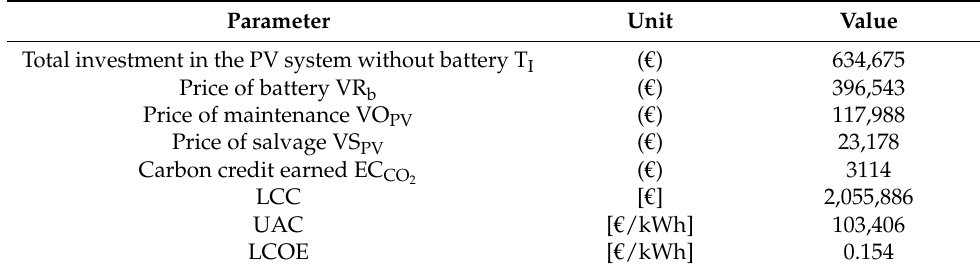
Table 8. Results of the LCOE analysis for the system with storage battery. Parameter